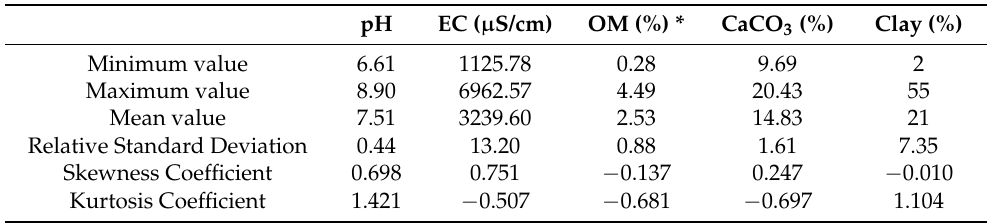
Table 1. Physicochemical properties of the soil samples before and during the lockdown period (mean values of the five years of study, n = 310). pH EC ( µ